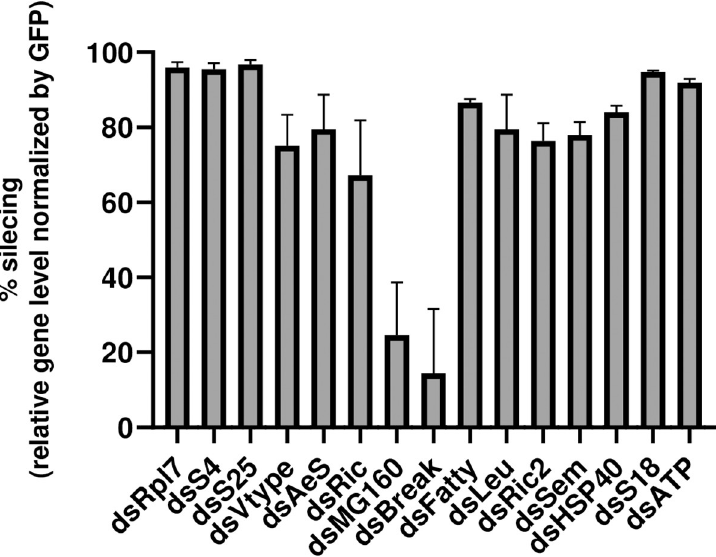
Fig 2. dsRNA silencing efficacy of A . aegypti genes in Aag2 cells. Hits from at least two experiments listed in Table 1 were knocked down in Aag2 cells using RNAi. At 48 h post-knockdown, silencing efficiency was analyzed by qRT-PCR, obtaining the relative levels of the specific gene normalized by Rp49 as housekeeping. Data is displayed as knockdown percentage of every hit compared to control (dsGFP). qRT-PCR analysis was done in pentaplicate, and the percentage of silencing was obtained comparing mean values of the relative gene levels between the specific genes and the GFP control (100%). Standard deviations are shown.